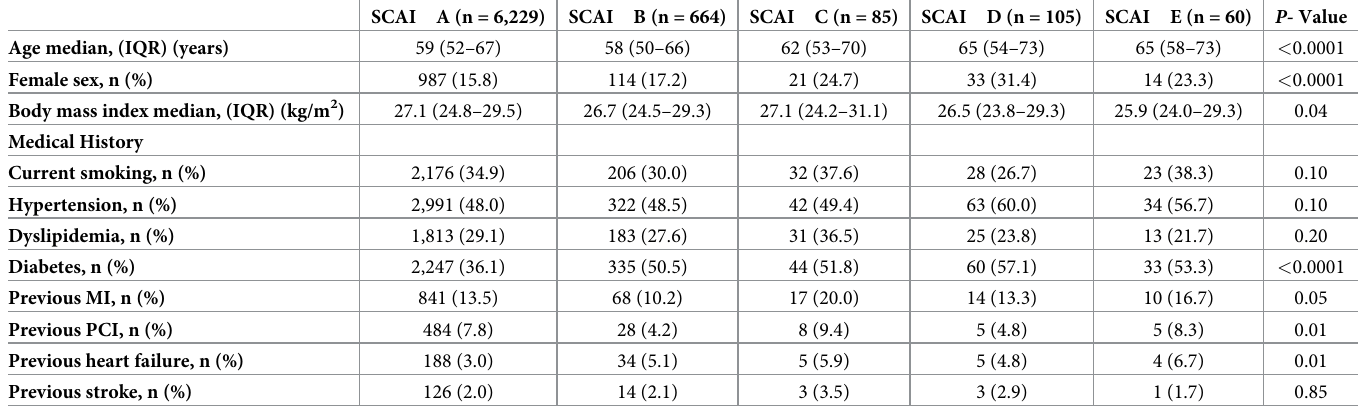
Table 1. Baseline characteristics of patients according to per society for cardiovascular angiography and intervention cardiogenic shock